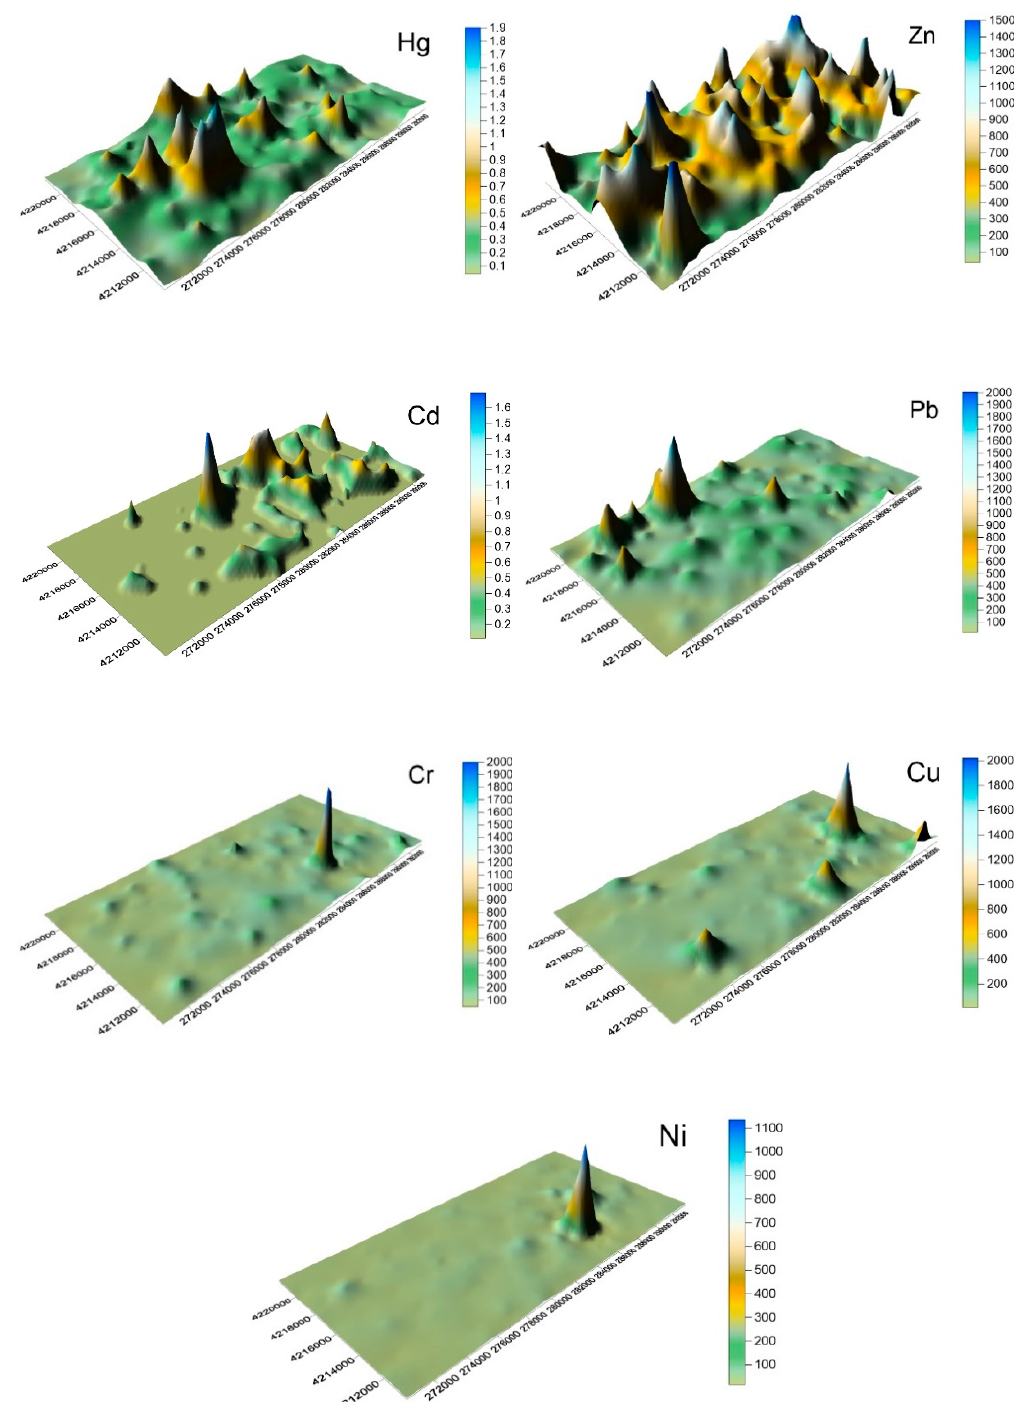
Figure 3. 3-D (three dimension) heavy metal distribution in Shijiazhuang street dust.